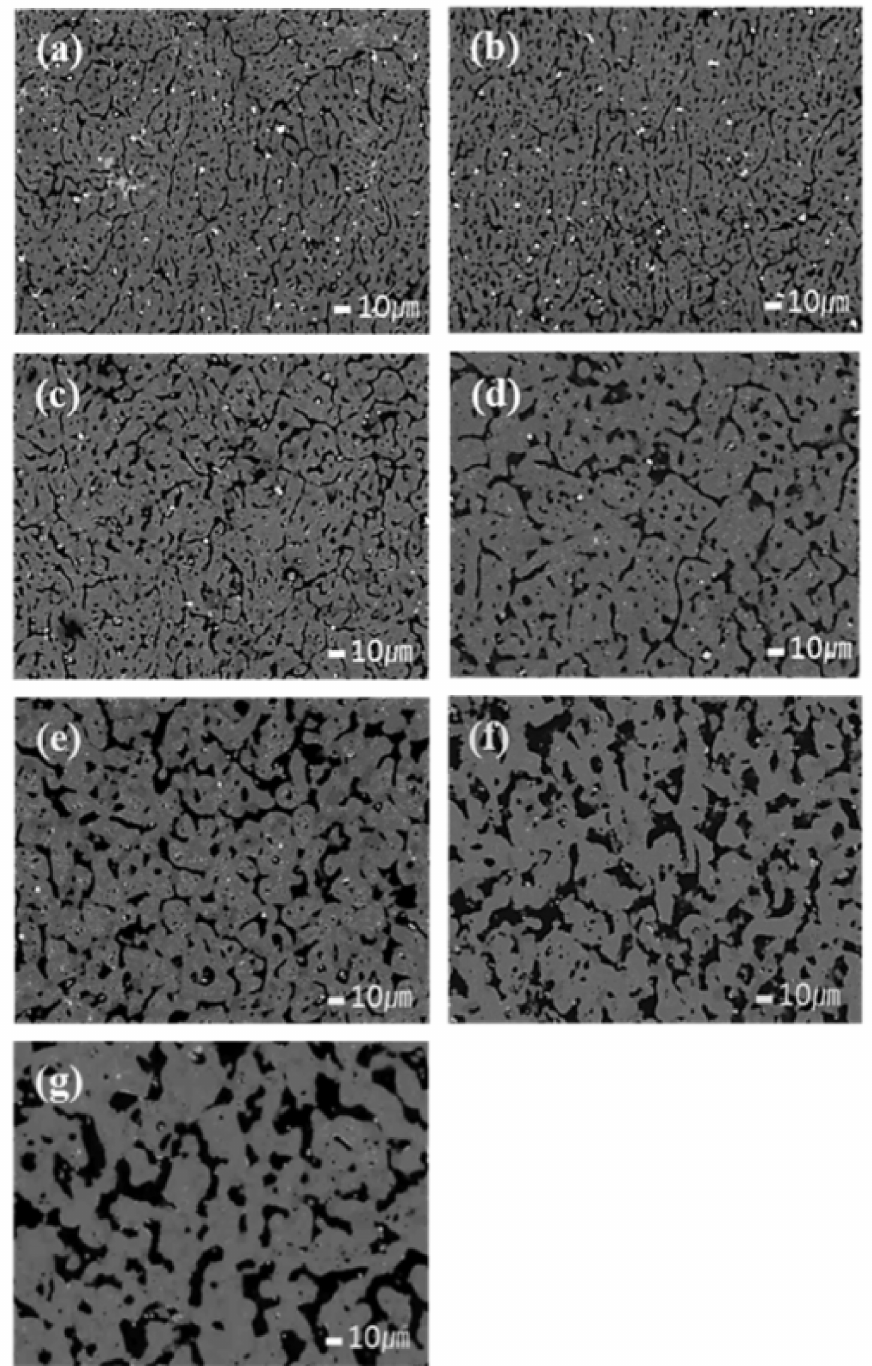
Figure 2. The microstructure of the reaction region in the magnet with Mg for different reaction times: ( a ) 30 min, ( b ) 1 h, ( c ) 3 h, ( d ) 6 h, ( e ) 12 h, ( f ) 24 h, and ( g ) 48